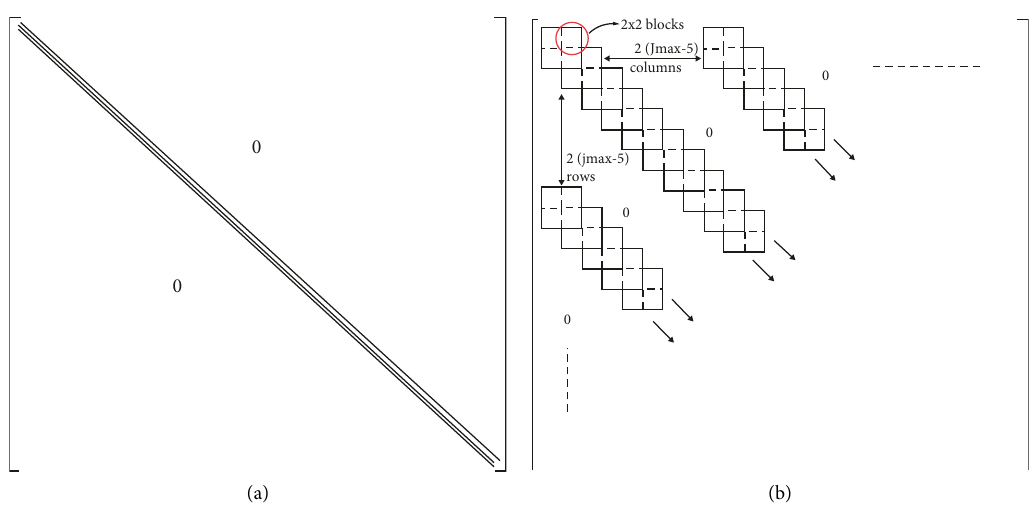
Figure 4: Matrix sparsity pattern. (a) Sparsity pattern. (b) Details of upper-left